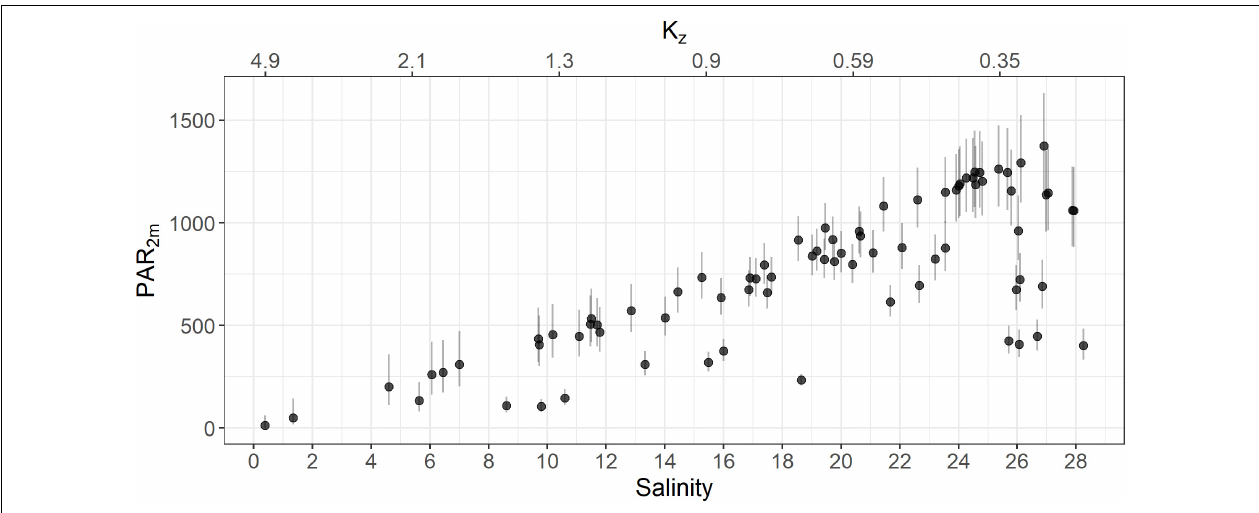
FIGURE 4 | PAR 2m for the entire ferry dataset as a function of salinity (solid circles). Error bars for PAR 2m were calculated using the upper and lower limits of the 95% confidence interval of k z . The estimated k z is shown on the secondary x -axis (top). Note that points exhibiting low PAR 2m and low k z represent samples from cloudy